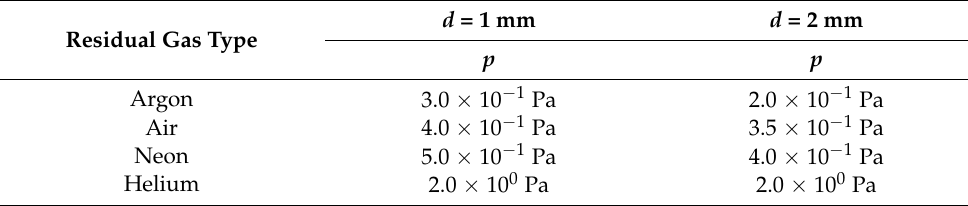
Table 3. The pressure range at which electrical strength measurements were made.